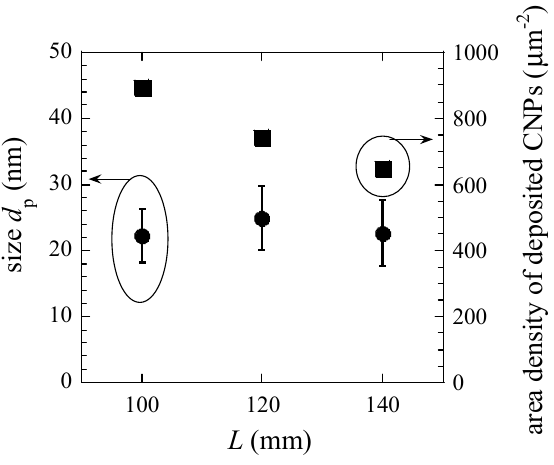
Figure 7. Dependence of the size and surface density of deposited CNPs on the position L far from the electrode for FR = 100 sccm. Error bar shows the standard deviation.